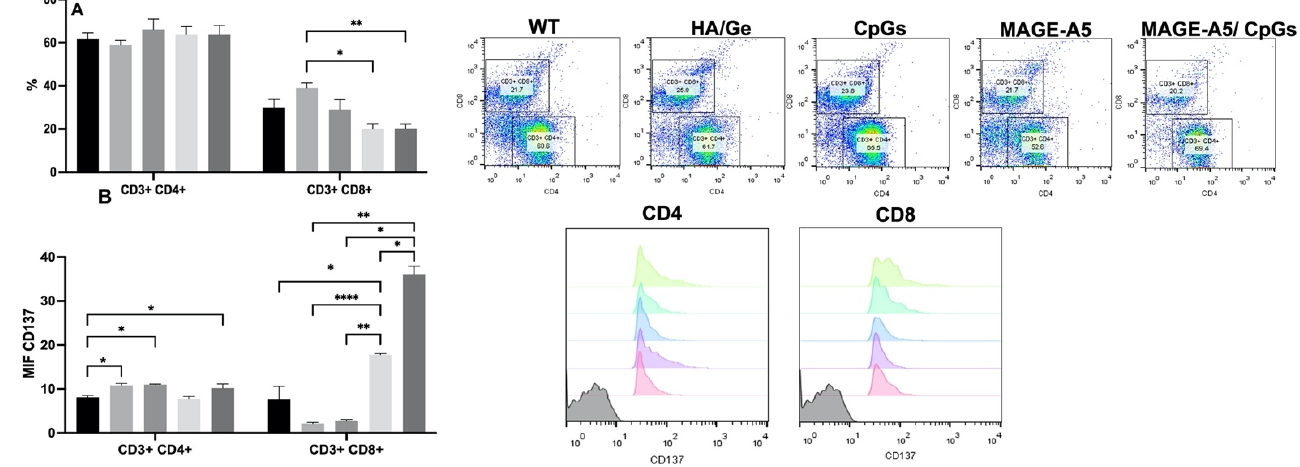
Figure 5. Percentage of T lymphocytes and expression of CD137 after treatment with Ge/HA scaffolds coupled to CpG and/or MAGE-A5. ( A ) Percentage of CD4 T lymphocytes. Without treatment, Ge/Ha, CpG, MAGE-A5, MAGE-A5/CpG. ( B ) Expression of CD137 in CD4 and CD8 T lymphocytes. No significant changes were observed in the percentage of CD4 T lymphocytes. CD8 T lymphocytes only showed an increase in the Ge/HA group compared to the Ge/HA/MAGE-A5 and Ge/HA/CpG/MAGE-A5 groups (* p = 0.01: Ge/HA vs. Ge/HA/MAGE-A5; ** p = 0.003: Ge/HA vs. Ge/HA/MAGE-A5/CpG). CD137 expression was enhanced in both CD4+ and CD8+ T lymphocytes. CD4 T lymphocytes showed higher levels of CD137 in the groups treated with Ge/HA, Ge/HA/CpG, and Ge/HA/CpG/MAGE-A5 than in the WT group (* p = 0.03: WT vs. Ge/HA, Ge/HA/CpG, Ge/HA/MAGE-A5/CpG). CD8+ lymphocytes showed the highest CD137 expression in the Ge/HA/MAGE-A5- and Ge/HA/CpG/MAGE-A5-treated groups compared to the WT groups (* p = 0.04 WT vs. Ge/HA/MAGE-A5; * p = 0.02: Ge/HA vs. Ge/HA/MAGE-A5/CpG; * p = 0.01: Ge/HA/CpG vs. Ge/HA/MAGE-A5/CpG; ** p = 0.005: Ge/HA/CpG vs. Ge/HA/MAGE-A5; ** p = Ge/HA vs. Ge/HA/MAGE-A5/CpG; **** p < 0.0001: Ge/HA vs. Ge/HA/MAGE-A5).